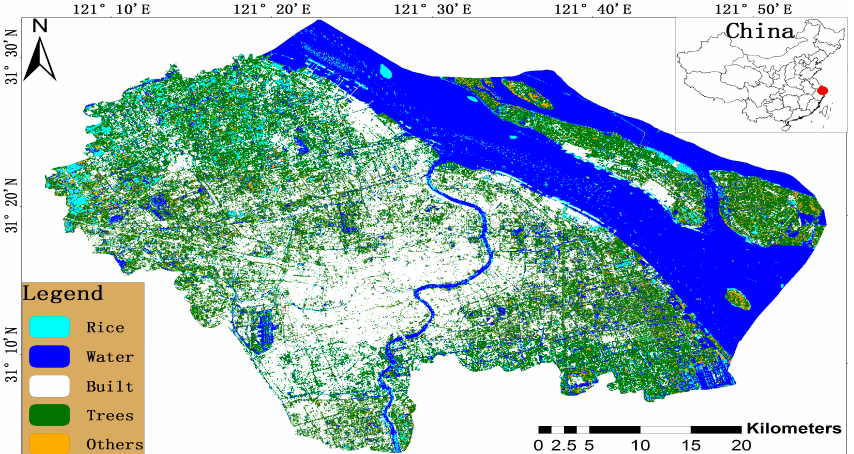
Figure 6. Simplified land-cover map of study area derived only from VH images of Sentinel-1A.